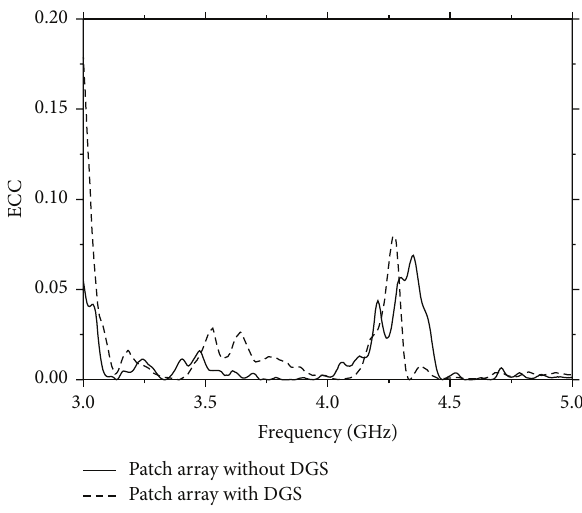
Figure 12: The measured envelope correlation of the patch array with and without